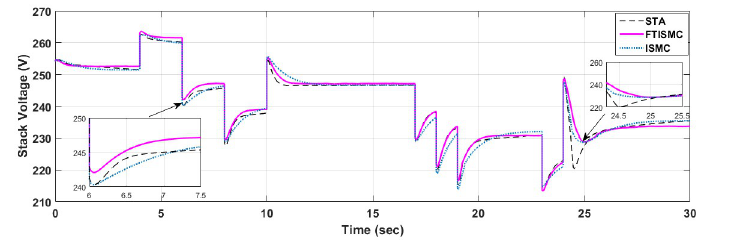
Fig 9. Stack voltage produced by fuel cell.